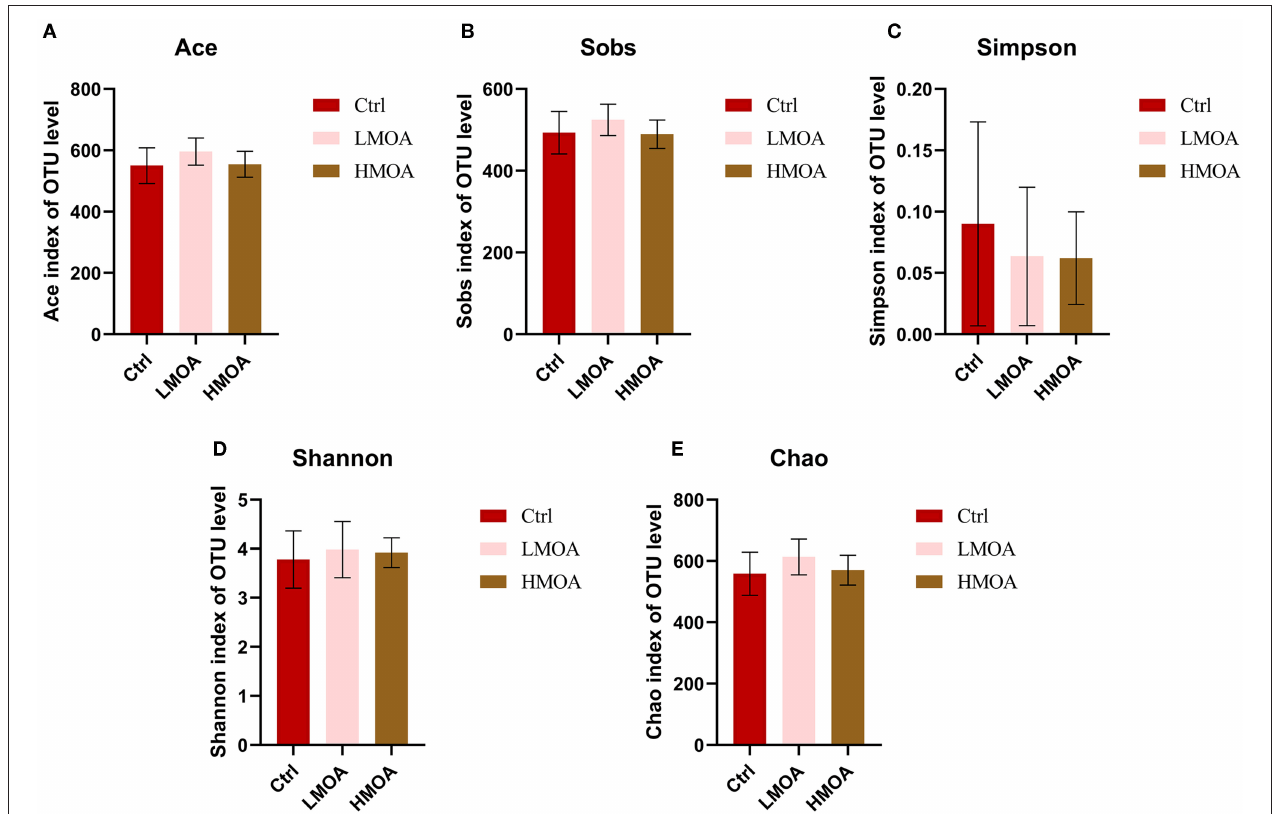
FIGURE 5 | The Bacterial abundance and α -diversity of the cecum in 42 d-broilers dietary with MOA supplementation were assessed by (A) Ace index, (B) Sobs index, (C) Simpson index, (D) Shannon index, and (E) Chao index of the operational taxonomic units (OTUs) community, respectively. The Shannon and Simpson indices represented the diversity of the intestinal microorganisms, while the Sobs, Ace, and Chao indices reflected the species richness. Ctrl: a basal diet of corn-soybean meal with 0 mg/kg of a mixed organic acid; LMOA: a basal diet with 3,000 mg/kg of mixed organic acids; HMOA: a basal diet with 6,000 mg/kg of mixed organic acids. The values were presented as mean ± standard error by the Kruskal-Wallis H test. n =